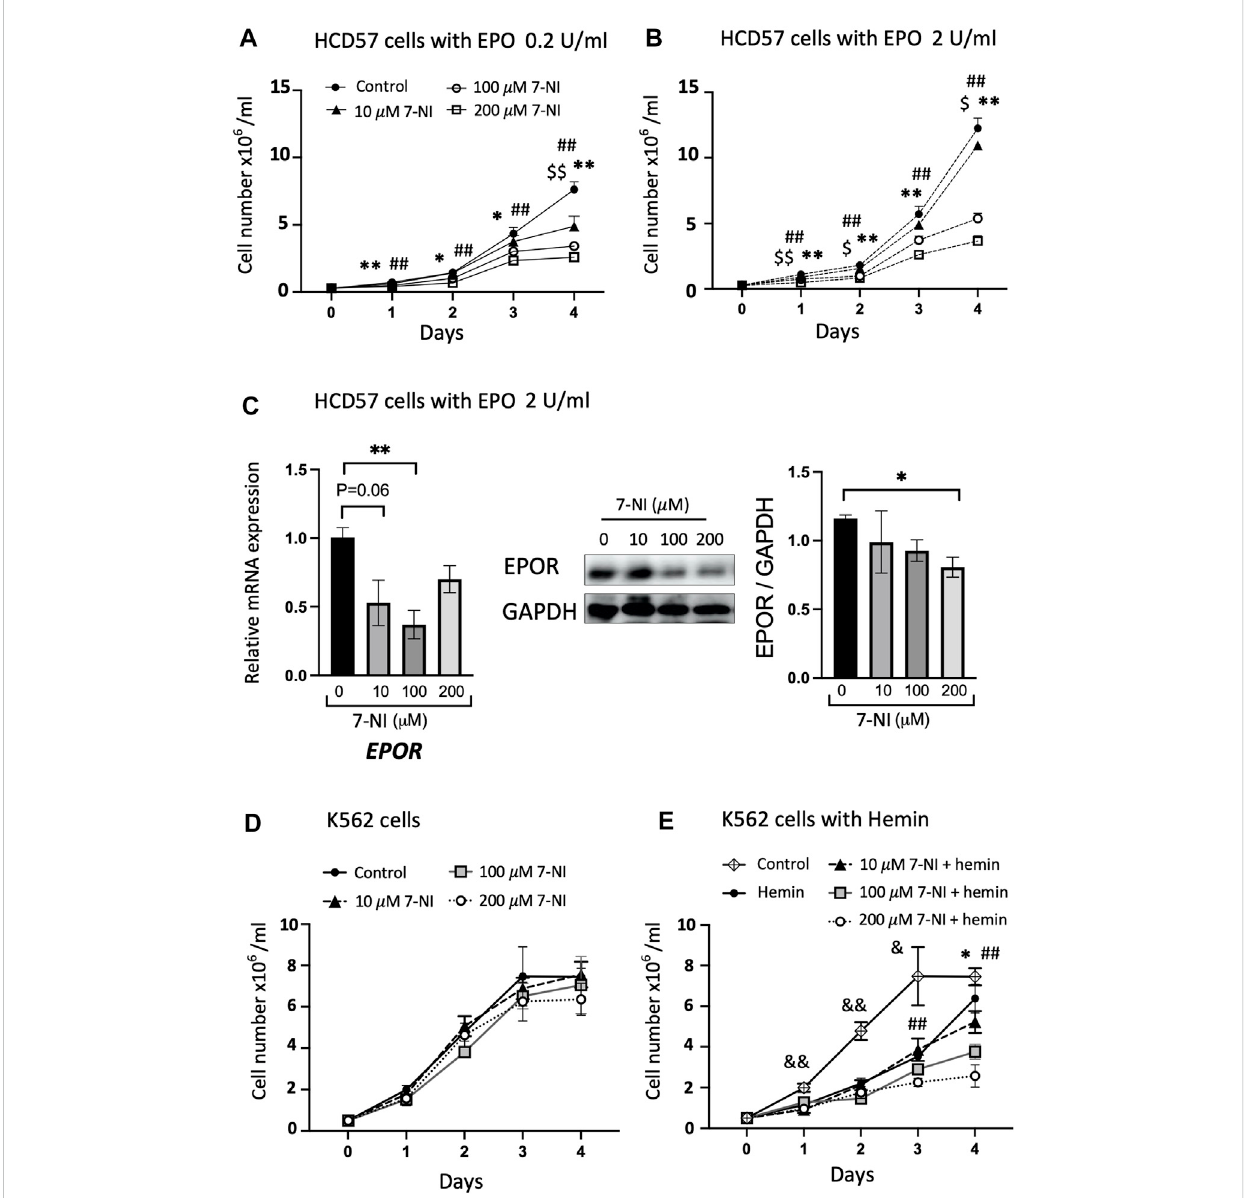
Inhibition of nNOS in proliferating erythroid cells. Treatment with nNOS inhibitor decreases proliferation of EPO-dependent HCD57 cells and proliferation of erythroid differentiating EPO-independent K562 cells. (A,B) Growth curves of EPO-dependent HCD57 cells cultured with 0.2 U/mL (A) and2 U/mL (B) EPOweredeterminedwithadditionofincreasingconcentrationsofnNOSinhibitor7-NI( n =3/group;indicatedare$,*,# p < 0.05,and$$, **, ## p < 0.01; $ means control vs. 10 μ M 7-NI, * meanscontrol vs. 100 μ M 7-NI, # means 200 μ M 7-NI). (C) EPOR gene expression (left panel) and EPOR protein expression determined by western blotting ( n = 3 – 4/group) in HCD57 cells were assessed with EPO treatment at 2 U/mL and increasing concentration of nNOS inhibitor. HCD57 cells were harvested at day 4. (D,E) Growth curves of EPO-independent K562 cells were determined with additionofnNOSinhibitorculturedwithout (D) andwith (E) hemininducederythroiddifferentiation( n =4/group;indicatedare&,*,# p < 0.05,and&&,**, ## p < 0.01; & means control vs. hemin, * means hemin vs. 100 μ M 7-NI + hemin, # means hemin vs. 200 μ M 7-NI + hemin).